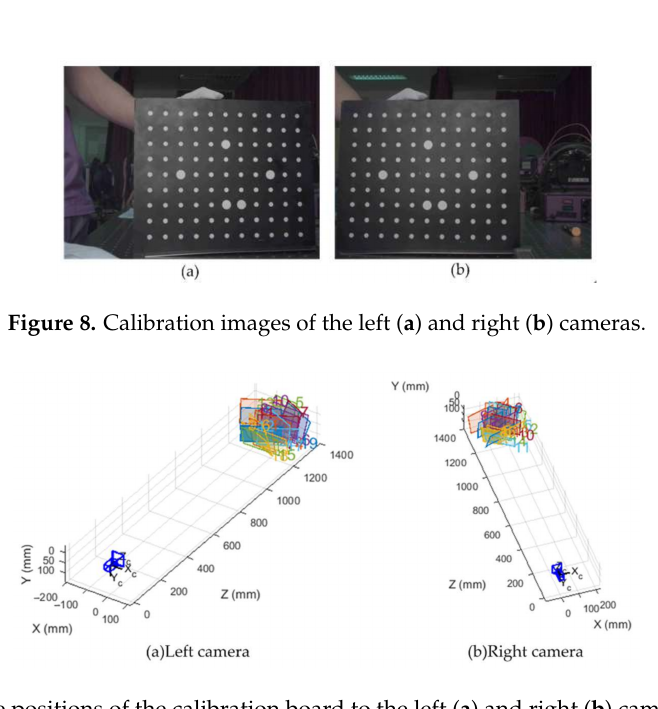
Figure 9. Relative positions of the calibration board to the left ( a ) and right ( b ) cameras. The optical center is the origin of the coordinate whereas rectangles in various colors represent the calibration boards in different